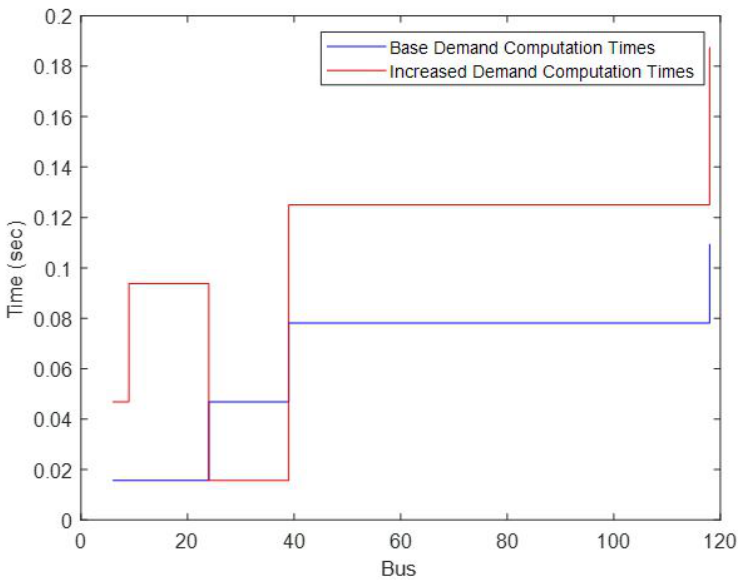
Figure 11. The network configurations of the base demand versus increase in demand computation